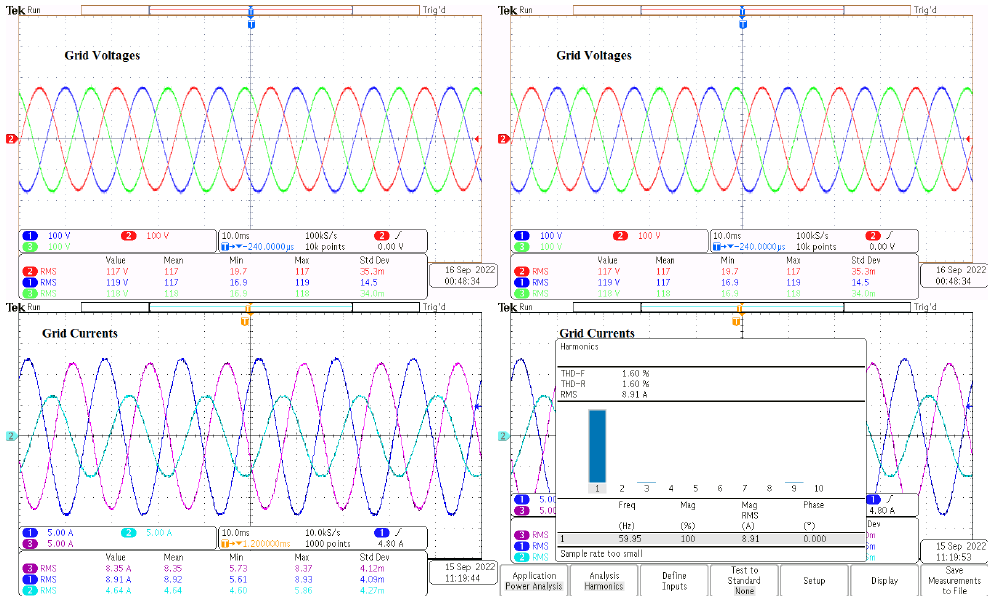
Figure 15. Experimental results before applying the proposed method under balanced grid inductances. 2.